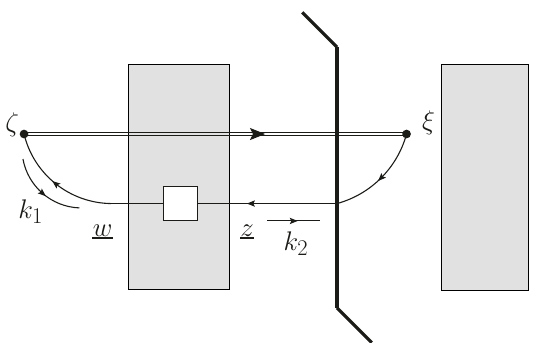
Figure 1. Diagram B with momentum and position variables shown in detail. The anti-quark with polarization χ 1 propagates from the position ζ to w with momentum k 1 , undergoes a sub-eikonal interaction with the proton which changes its transverse position from w on the left of the shock wave (the left shaded rectangle) to z on the right of the shock wave and its polarization from χ 1 to χ 2 . The anti-quark then propagates from z to the position ξ with momentum k 2 . The shock wave is denoted by the shaded rectangle, while the sub-eikonal interaction with the shock wave is denoted by the white